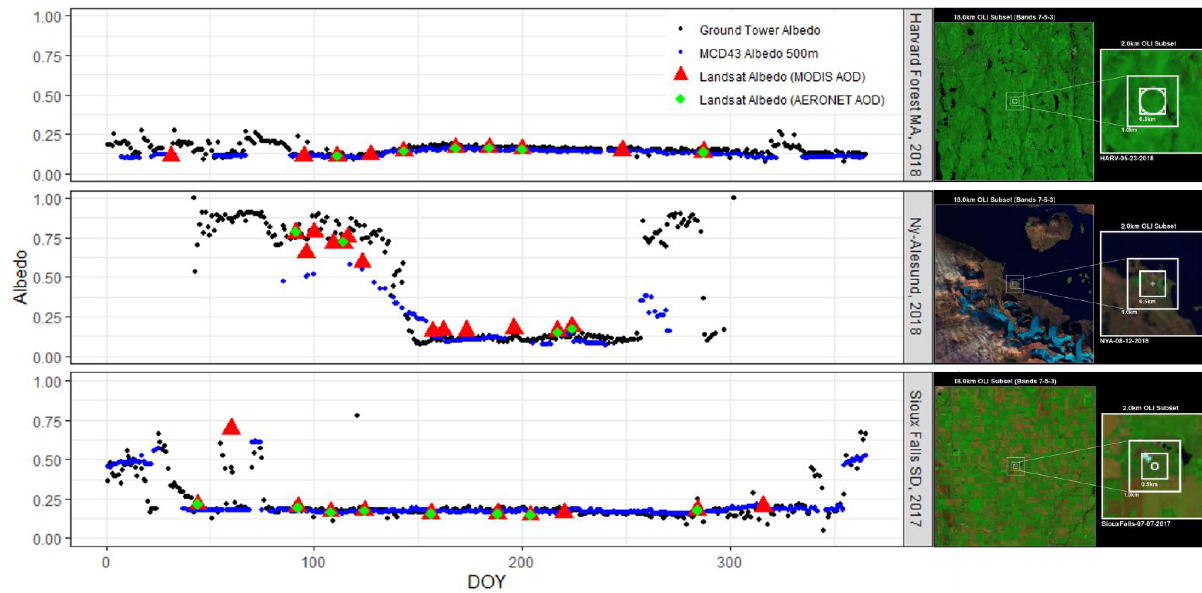
Figure 4. Temporal comparison of Landsat and MODIS albedo products with Landsat albedo shown in red and green for MODIS and AERONET AODs, respectively, MODIS albedo at 500 m resolution in blue and the tower albedo in black. Insets of the tower footprints and surrounding landscape at each site are shown for summer months. Missing AERONET data points largely result from unavailable Level 2.0 AOD information.